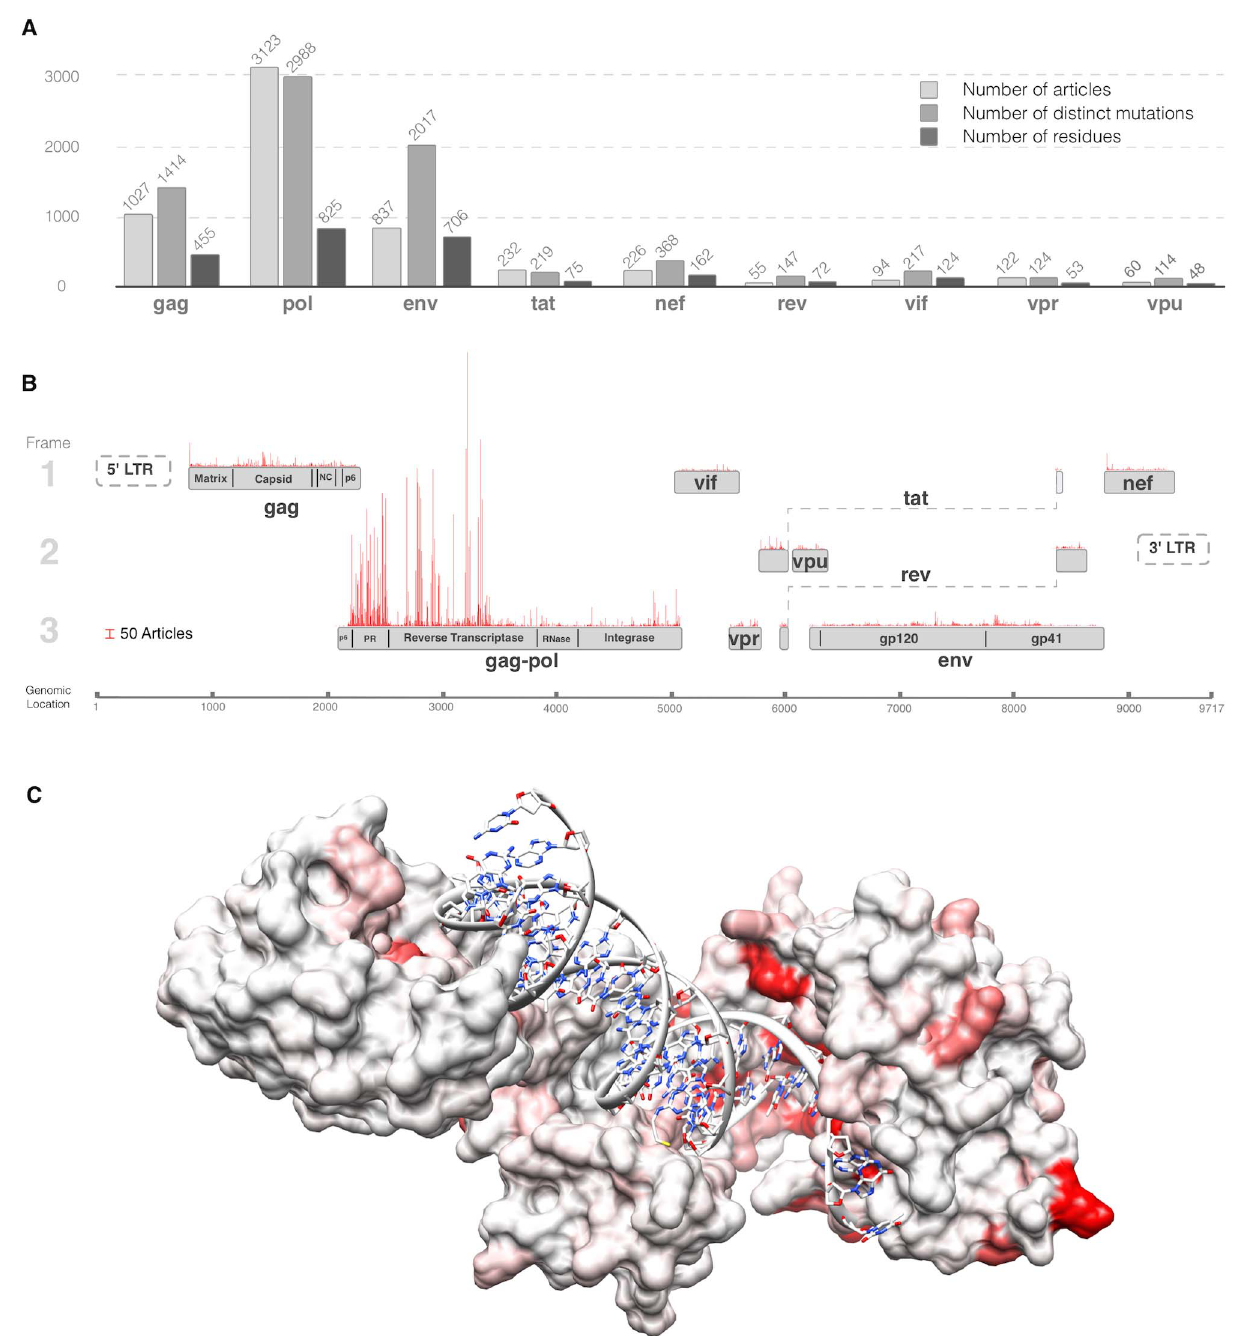
Figure 2. Overview of the distribution of mutation data across the HIV proteome. (A) Barplot of the counts of (i) the number of articles describing mutations, (ii) the number of distinct mutations and (iii) the number of residues with mutation data in the database for each protein in the HIV proteome. (B) Barplot of the counts of the number of curated articles in the database describing mutagenesis experiments or polymorphisms for each residue mapped onto the HIV proteome/genome. (C) Reverse transcriptase p66 subunit with residues coloured by number of articles referring to them. Most highly cited residues are in contact with the nucleotides or are known drug resistance mutations. White denotes no papers, full red denotes 50 or more papers, colouring is linearly scaled between 0 and